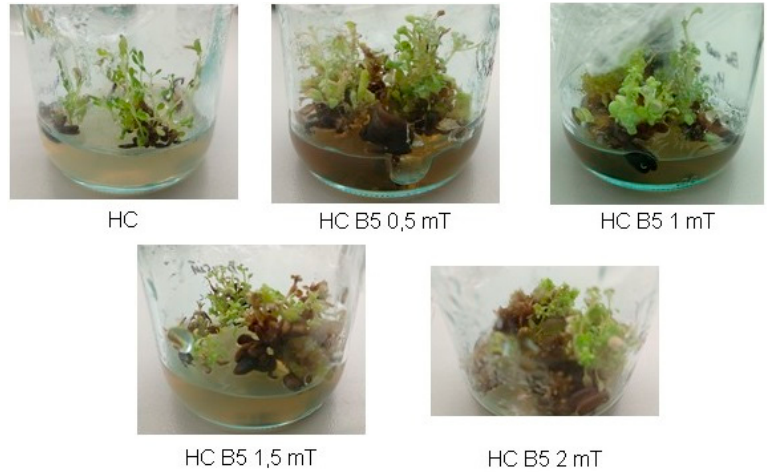
Figure 3. The effect of different concentrations of m T on plants of H. cretaceus shoots in vitro . The highest average value of the multiplication coefficient of M. fragrans shoots in